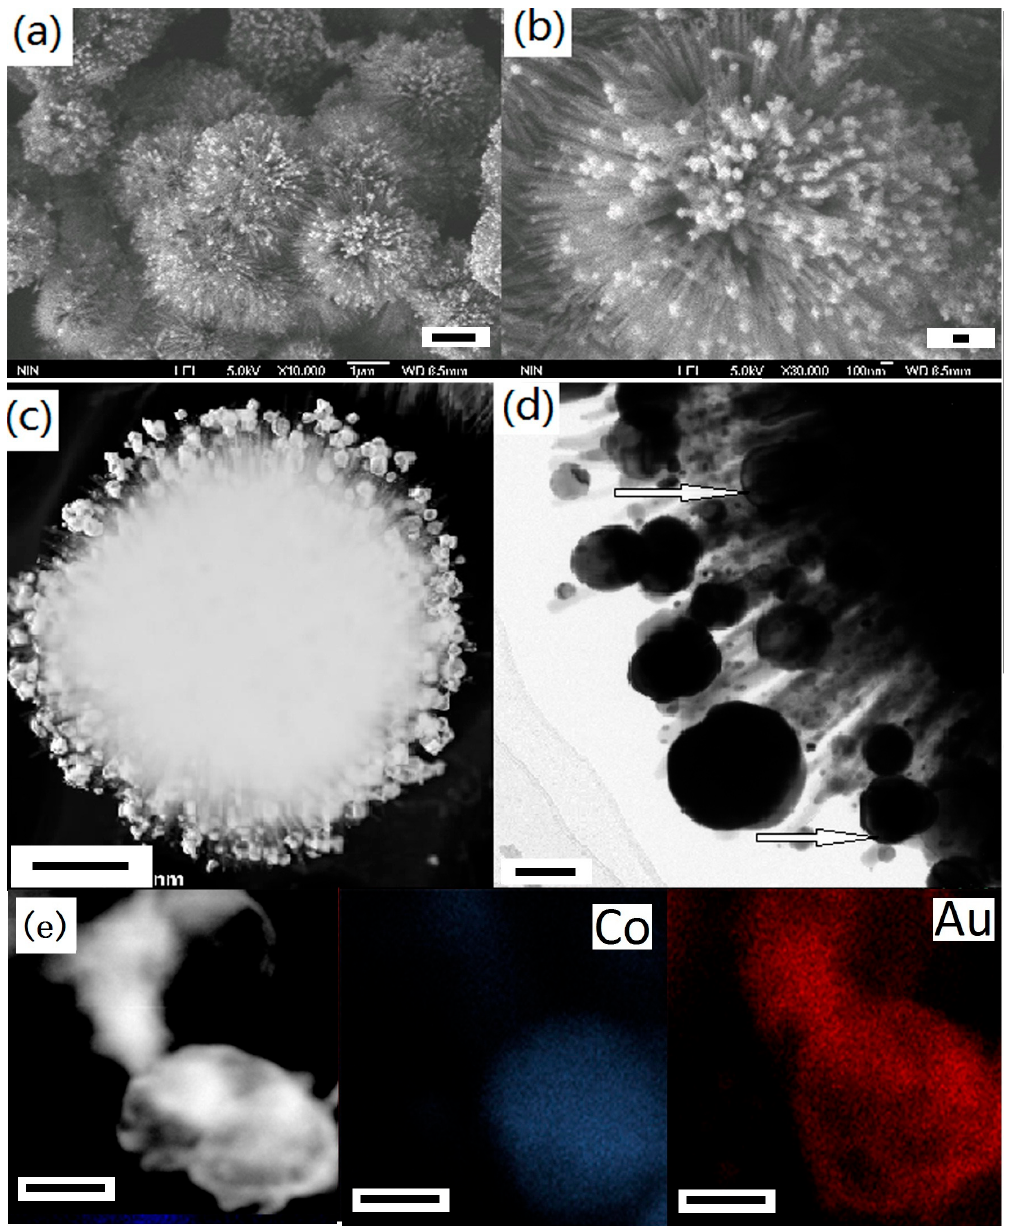
Figure 15. The SEM and TEM images of Co@Au/TiO 2 composites: ( a , b ) SEM images, ( c , d ) TEM images, ( e ) high-resolution TEM images; ( e ) the local elemental mapping of Co and Au (Scale bar = 1 µ m for ( a ); scale bar = 100 nm for ( b ); scale bar = 500 nm for ( c ); scale bar = 100 nm for ( d ); scale bar = 50 nm for ( e )) [32].